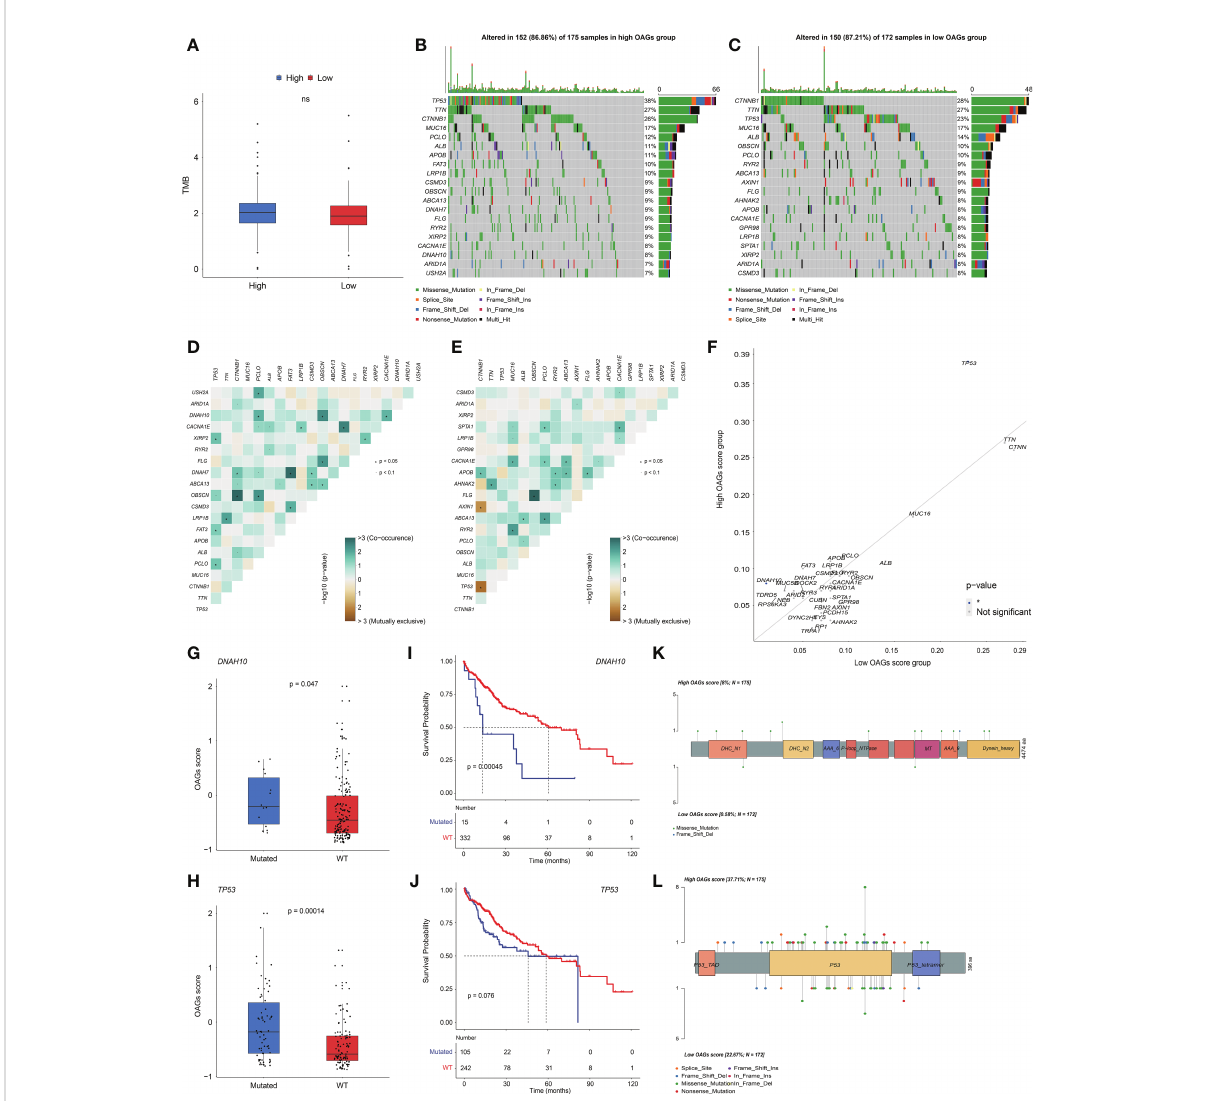
FIGURE 6 OAG score associated with distinct somatic genome. (A) The evaluation of TME level between high and low OAG score groups. (B) Oncoprint plot for genomic alterations of patients from high OAG score group. (C) Oncoprint plot for genomic alterations of patients from low OAG score group. (D) The heatmap of mutually co-occurrence and exclusive alterations of the top 20 altered genes in high OAG score group. (E) The heatmap of mutually co-occurrence and exclusive alterations of the top 20 altered genes in low OAG score group. (F) The somatic alteration enrichment analysis for high and low OAG score groups. (G) DNAH10 somatic alteration associated with OAG score. (H) TP53 somatic alteration associated with OAG score. (I) Kaplan – Meier curve analysis between patients with DNAH10 somatic alterations or not. (J) Kaplan – Meier curve analysis between patients with TP53 somatic alterations or not. (K) The pro fi ling of alteration sites of DNAH10 somatic alterations between high and low OAG score groups. (L) The pro fi ling of alteration sites of TP53 somatic alterations between high and low OAG score groups.